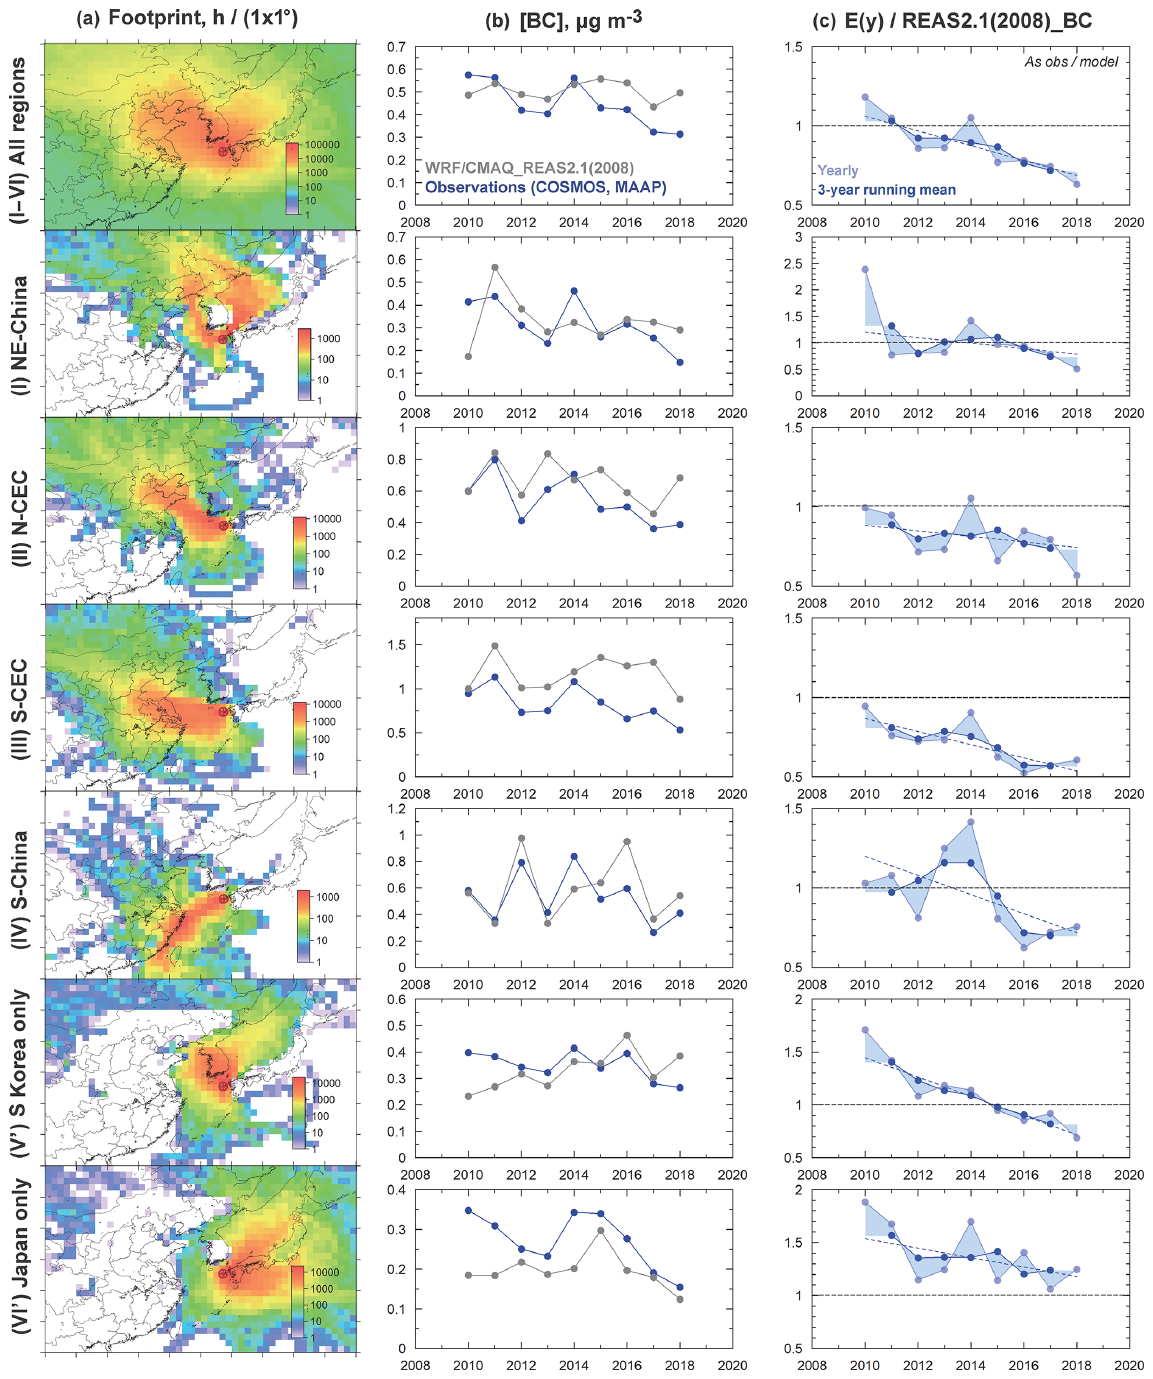
Figure 5. (a) Footprints, (b) annually averaged black carbon (BC) concentrations for observations (blue dots) and model simulations (gray dots), and (c) observed/modeled BC concentration ratios used to estimate the emission correction factors – E( y )/REAS2.1(2008) – for all regions (I–VI) and individual regions (from top to bottom, as labeled on the left) for all seasons. NE China – northeastern China; N-CEC